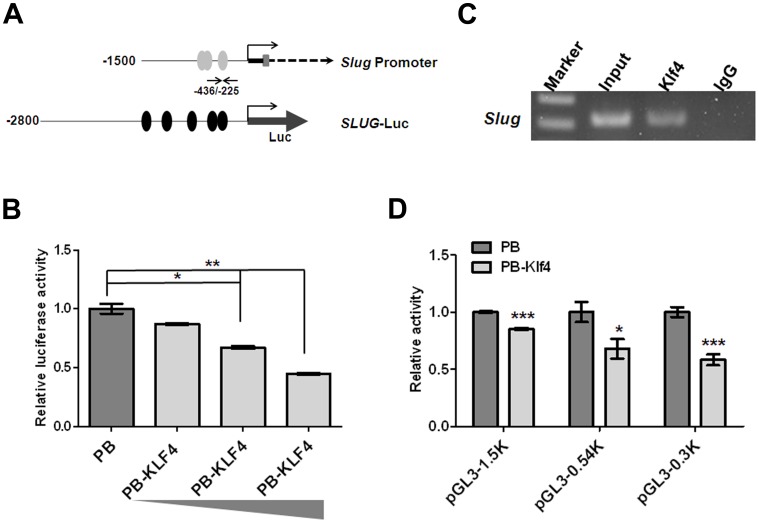
Klf4 bound and repressed the Slug promoter.(A) Schematic representation of Slug gene structure containing 1500 bp of promoter region (Slug promoter) and SLUG luciferase construct (SLUG-Luc). Grey ovals (Klf4) represented GC-boxes containing putative Klf4 binding sites predicted using MatInspector; black ovals (KLF4) represented putative KLF4 binding sites predicted using MatInspector. Black arrows depicted the location of the forward and reverse primers used for PCR amplification from immunoprecipitated DNA fragments. (B) SLUG promoter activity was reduced due to ectopic KLF4 expression in a dose-dependent manner. The SLUG-Luc reporter plasmid or pGL3-basic was co-transfected with Renilla-expressing control (pRL-TK) and KLF4-expression plasmids into 293T. The relative luciferase activity was defined as luciferase value, normalized to Renilla levels, was shown as –fold change over vector control. Bar, SE. *, p<0.05; **, p<0.01. (C) ChIP assay of Klf4 on the Slug promoter. A Klf4 antibody or IgG serum was conducted to immunoprecipitate DNA-protein complexes from MM189 cells with ectopic Klf4 expression (MM189 PB-Klf4). Binding of Klf4-containing transcription complex on the Slug promoter was enriched over IgG control. Representative amplification of PCR products, using the primers described in (A) was shown. Independent ChIP experiments were performed at least twice. (D) Slug promoter activity was reduced due to ectopic Klf4 expression. Different sizes of the Slug-Luc reporter plasmids were individually co-transfected with Renilla-expressing control (pRL-TK) and Klf4-expression plasmids or vector controls into 293T. The relative luciferase activity was defined as luciferase value, normalized to Renilla levels, was shown as –fold change over vector control. Bar, SE. *, p<0.05; ***, p<0.001.